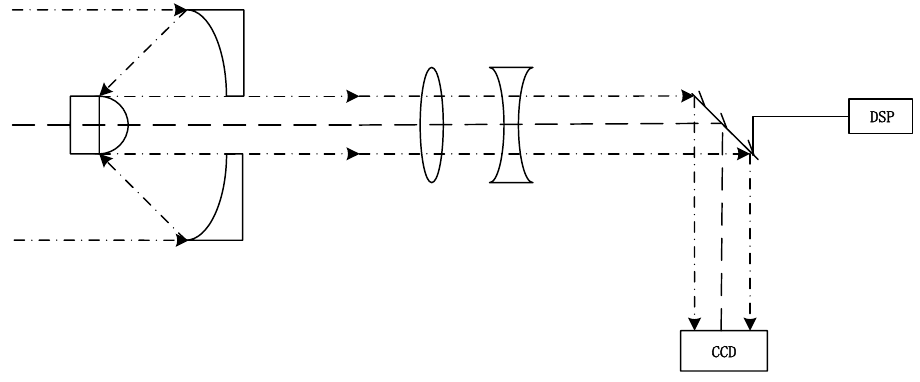
Figure 1. Reflective infrared micro-scanning optical model.